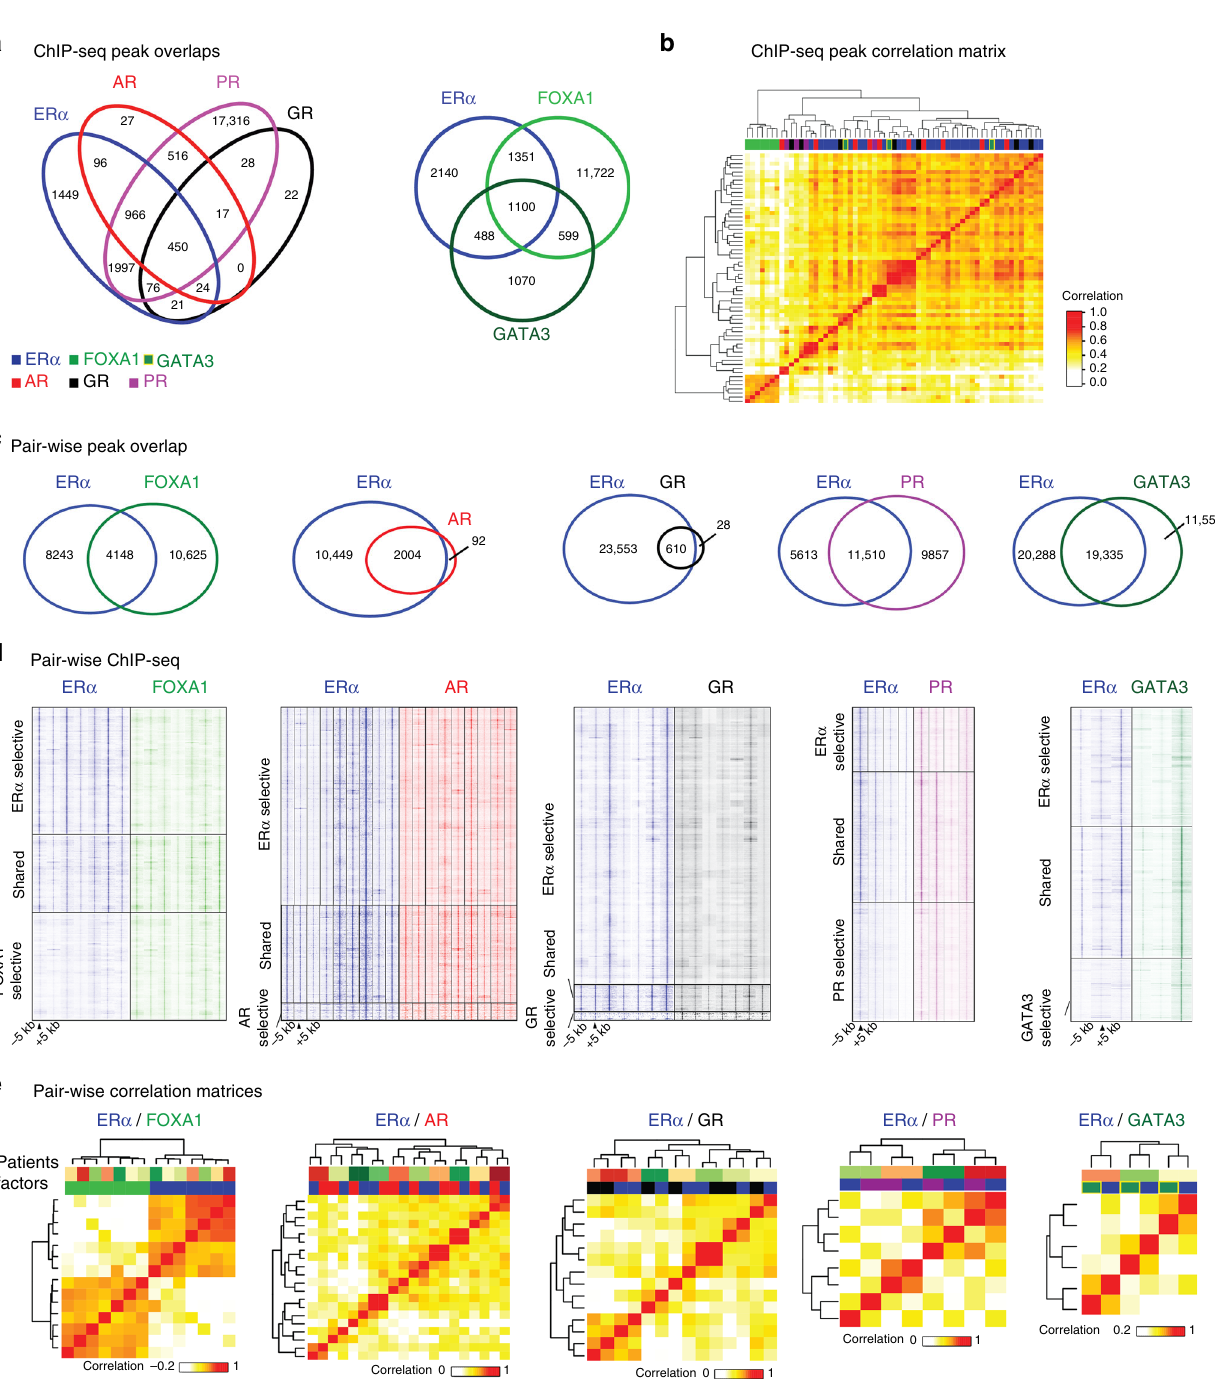
Fig. 2 Multifactorial ChIP-seq data integration. a Venn diagram depicting the overlap of ER α with steroid hormone receptors (left) and overlap of ER α with FOXA1 and GATA3 (right). b Unsupervised clustering correlation matrix of bound regions among all factors. Top bar indicates the factors: ER α (blue), AR (red), PR (purple), GR (black), FOXA1 (light green), and GATA3 (dark green/orange border). Pearson correlation is depicted from 0 (white) to 1 (dark green). Sites used to construct the matrix are the union of all consensus binding sites of the factors. c Individual Venn diagrams depicting the pairwise overlap of ER α with each factor. Consensus binding sites for each factor were used (Fig. 1d), and overlap with ER α sites from the same tumors was assessed, taking the same threshold. d Heatmaps indicating the binding peak intensity for each combination in ( c ). In each panel, ER α (left) and factor (e.g., FOXA1, right) ChIP-seq data are depicted. Shown are peaks selectively observed for ER α (top), selectively observed for other factors (bottom), or shared between them (middle). e Correlation heatmap for ChIP-seq data sets between ER α and the other factors. Colors in top bar indicate patient (top)